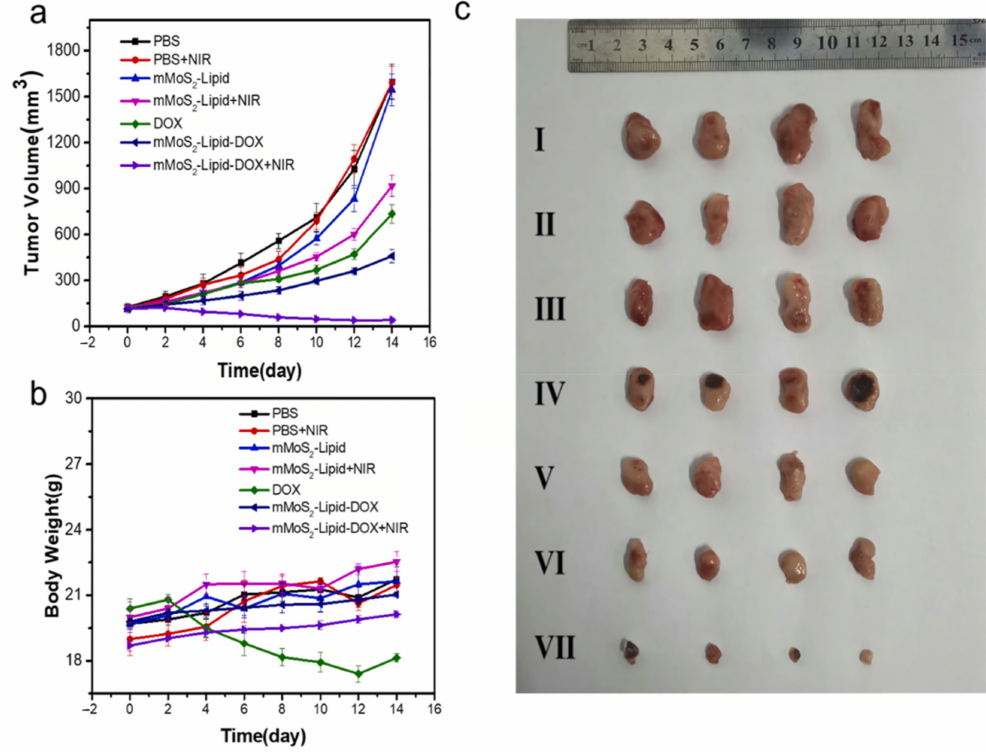
Figure 10. The changing curve of tumor volume from the beginning to the end of treatment (mean ± SD, n = 4) ( a ). The weight change curve of mice in each group (mean ± SD, n = 4) ( b ). The tumor image of different groups of mice on the 14th day following the treatment (mean ± SD, n = 4) ( c ). Reprinted from [106] with permission of Elsevier provided by Copyright Clearance